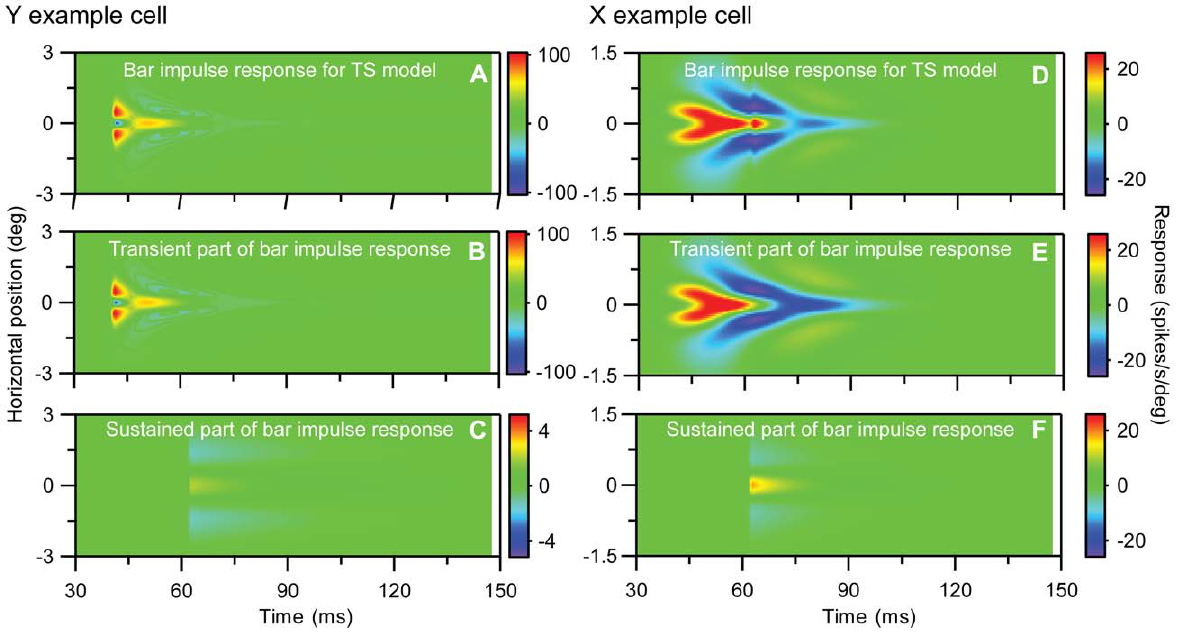
Figure 12. Predicted ‘one-dimensional impulse response’, i.e., impulse response for long and thin bars, for the transient-sustained (TS) model for example on-center Y and X neurons in Figs. 1 and 2. This impulse-response function of the form given in Eq. (16), but with the spatial functions g m ( r ) replaced by the function g bar,m ( x ) listed in Eq. (21). The test bar in the example has a length L =10 deg. All model parameters correspond to the fit depicted in Fig. 10 and are listed in Table 1. A. Predicted receptive-field function for full TS-model for Y neuron. B. Contribution from transient part ( f t1 ( t ) g bar,t1 ( x ) + f t2 ( t ) g bar,t2 ( x )). C. Contribution from sustained part ( f s ( t ) g bar,s ( x )). D – F. S ame as (A)–(C) for the X-neuron. Notice that (i) the color scale in C and F differ from the scale in the other corresponding color maps and (ii) that the negative response for the Y-neuron has been truncated at the numerical value 2 100 spikes/s/deg in panels A and B.